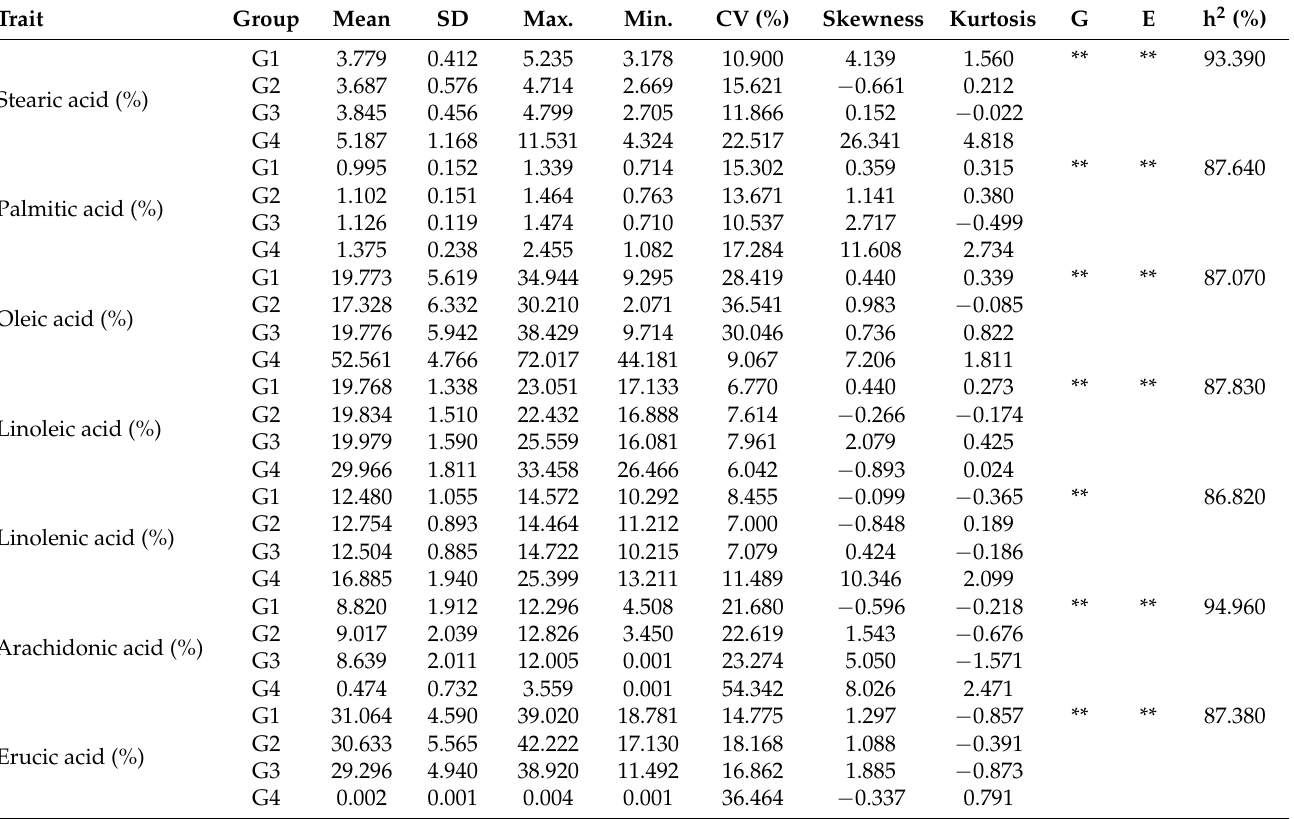
Table 1. Mean value of some agronomic characters in each genetically distinct